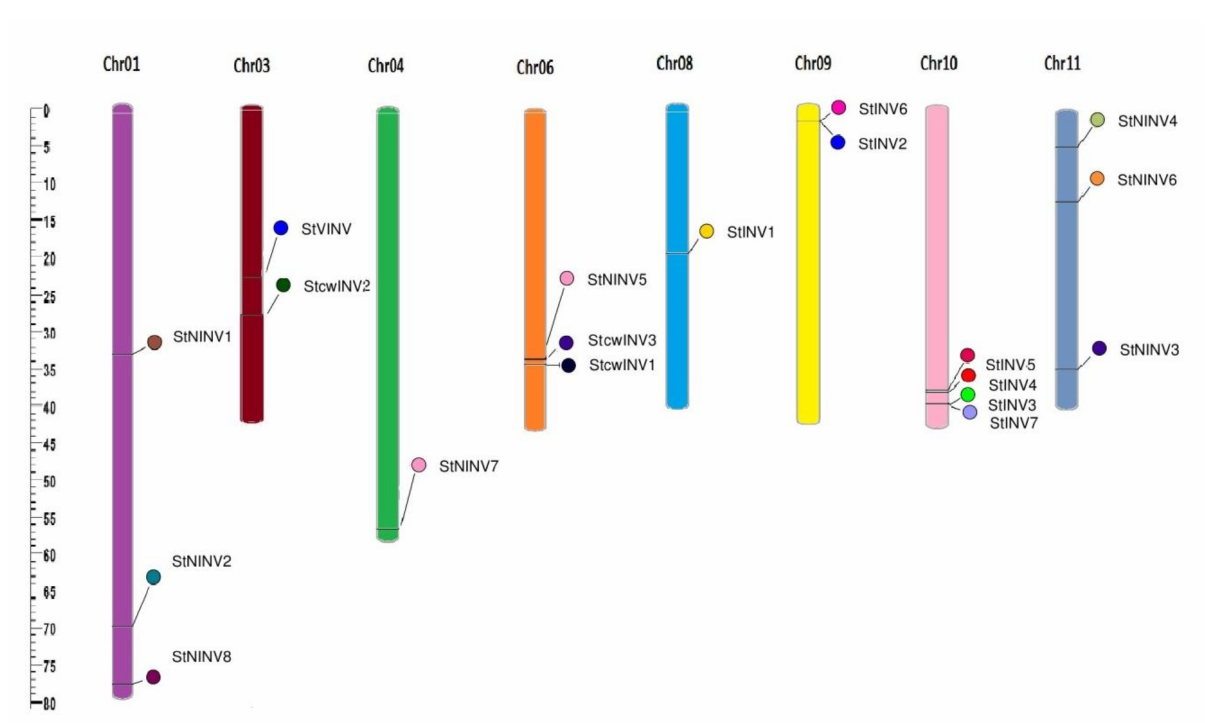
Figure 2. Locus map of invertase genes from Solanum tuberosum . Chromosomes are numbered and represented in different colors, whereas genes are represented at their